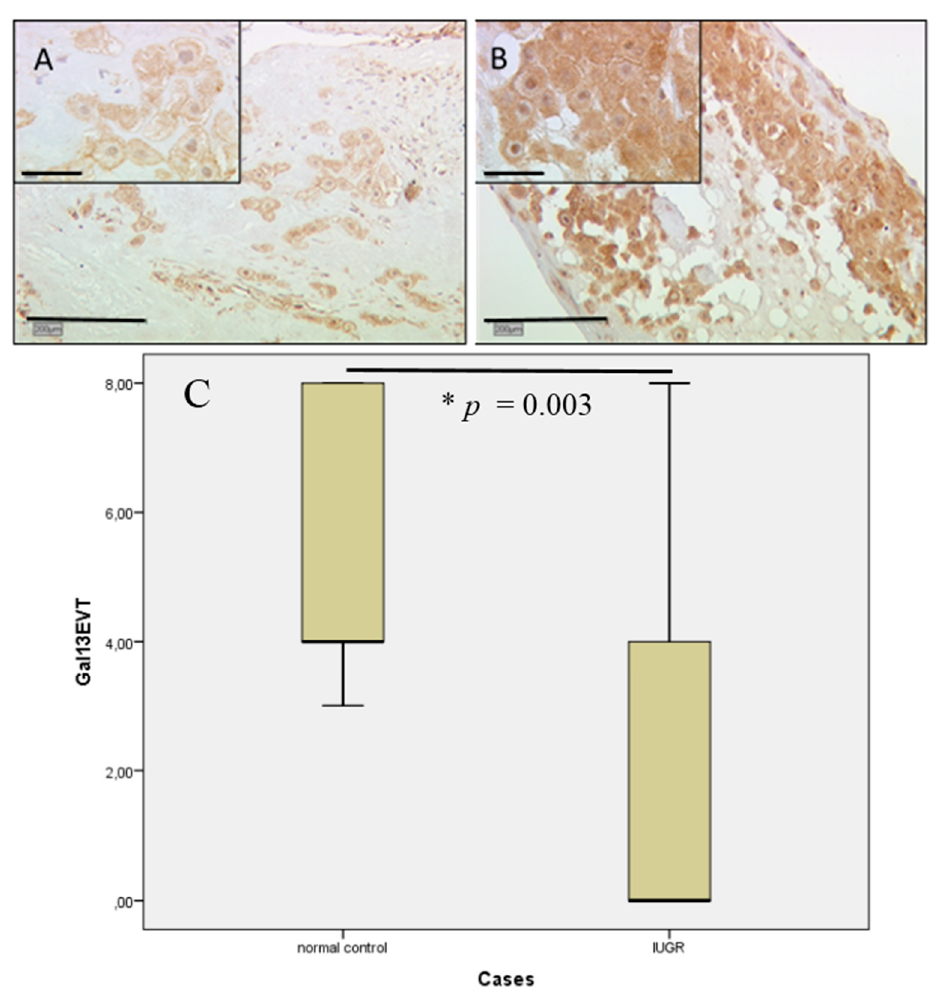
Figure 6. In IUGR placentas, gal-13 expression in extravillous trophoblasts was rarely detectable. IRS scoring revealed only weak to no expression ( A ); control placentas showed intermediate expression for gal-13 ( B ); again, all results were statistically significant (* p = 0.003). In summary the scoring result is presented in box-plot form ( C ). For details of the box-plot interpretation, see the legend of Figure 2.